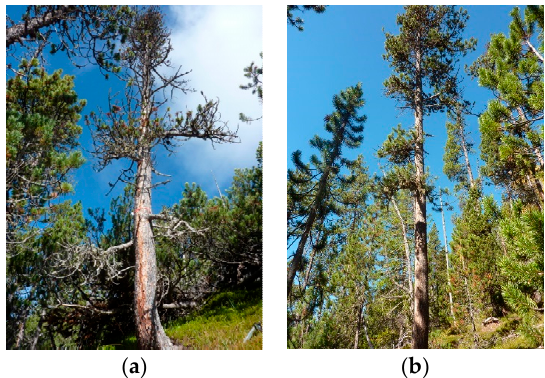
Figure 2. Declining( a ) and healthy ( b ) mountain pine trees from the study site at the Swiss National Park.